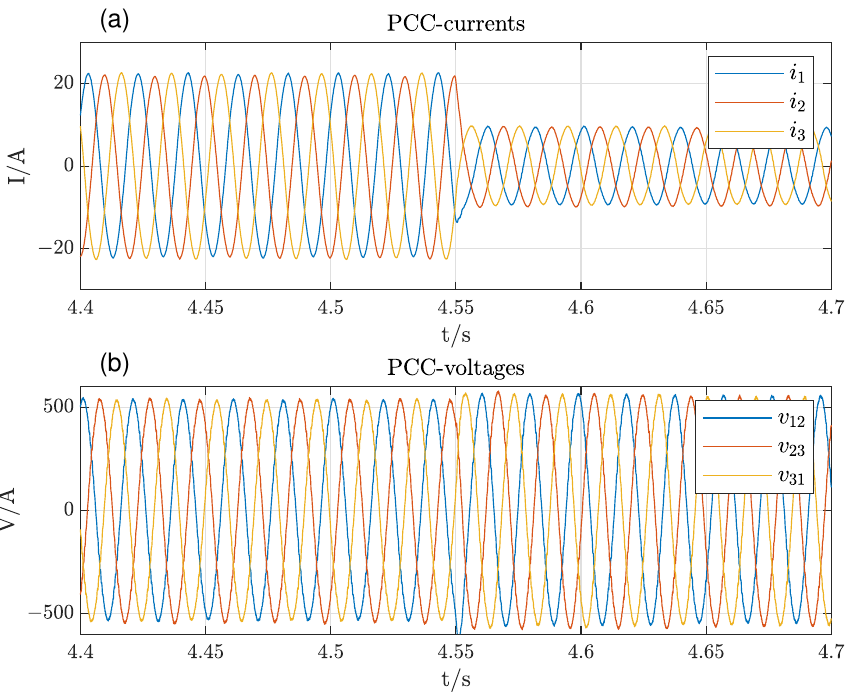
voltage drop across the line filter, see Figure 11b. The frequency is not constant anymore in islanded operation but varies slightly according to the implemented frequency droop.